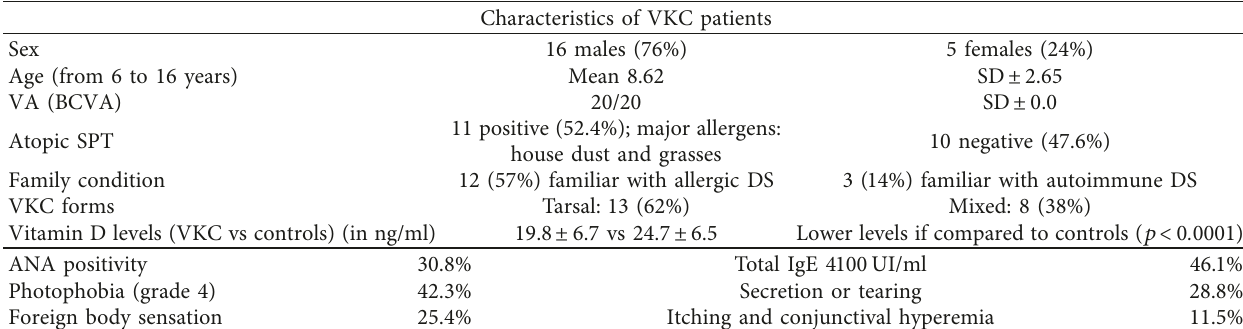
Figure 1: Patient affected from vernal keratoconjunctivitis (VKC). (a) Mixed form with cornel signs limbar neovascular and (b) tarsal papillae on the superior conjunctiva. Table 1: Demographics and clinical grading of 21 vernal keratoconjunctivitis (VKC)